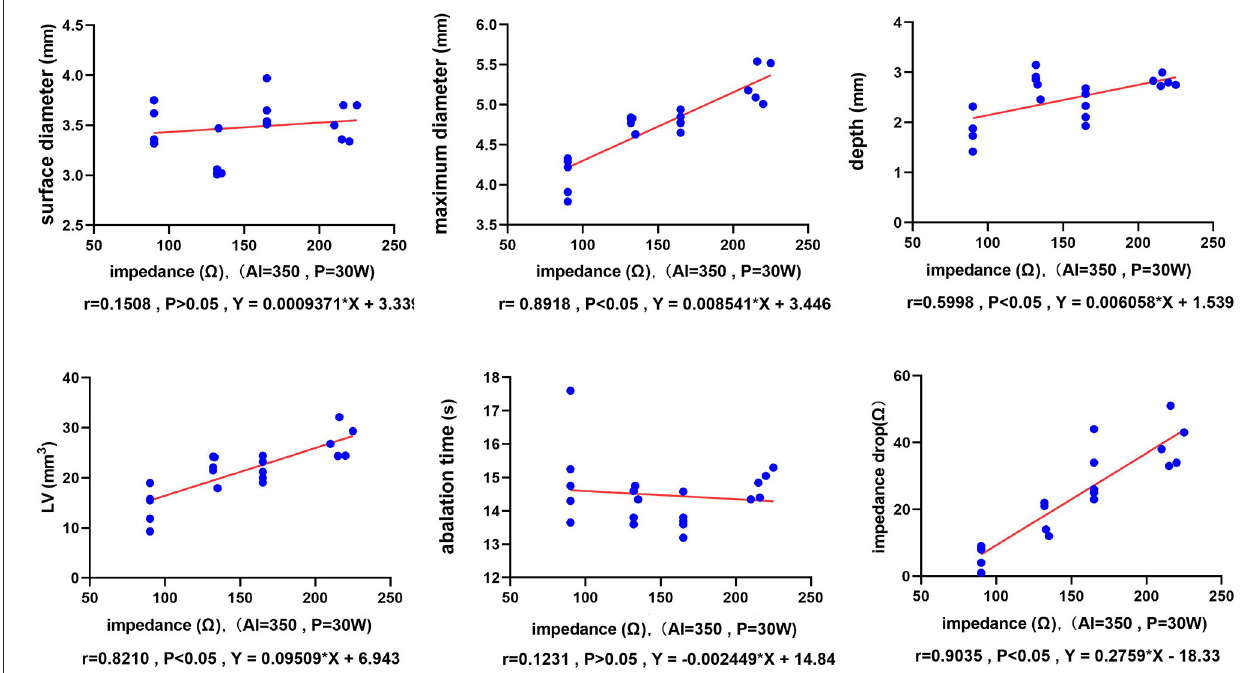
FIGURE 4 | The relationship between the ablation parameters and the lesion dimensions. The six-line graphs show the correlations between the baseline R and the ablation time (T), the R drop, and the lesion size. Each dot represents an individual radiofrequency-ablated lesion. The red line is the fitted linear regression line.